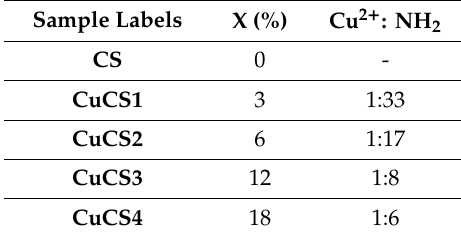
Table 4. Amounts of Cu 2 + in CS with di ff erent molar ratios and crossonding sample labelling. Sample Labels X (%) Cu 2 + : NH